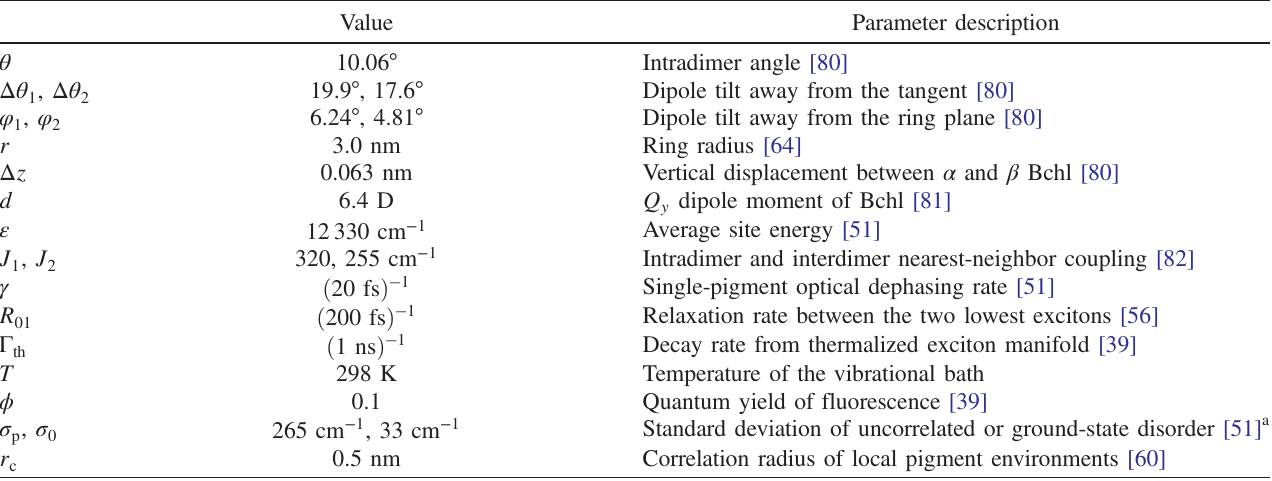
FIG. 6. Geometry of a B850 ring. We show projections on the xy plane (top) and on the xz plane (bottom) of a B850 ring lying on the xy plane. The z direction is magnified by a factor 10, and the angles φ 1 and φ 2 are rescaled accordingly. The fluctuations of the site energies δε are given by the i sum of two Gaussian random variables: one with standard deviation σ , completely uncorrelated for different pig- p ments, describing local energy shifts due to the slightly different protein environments; one with standard deviation σ 0 , which is the same for all pigments, describing global shifts of the ground-state energy. TABLE II. Model parameters for a B850